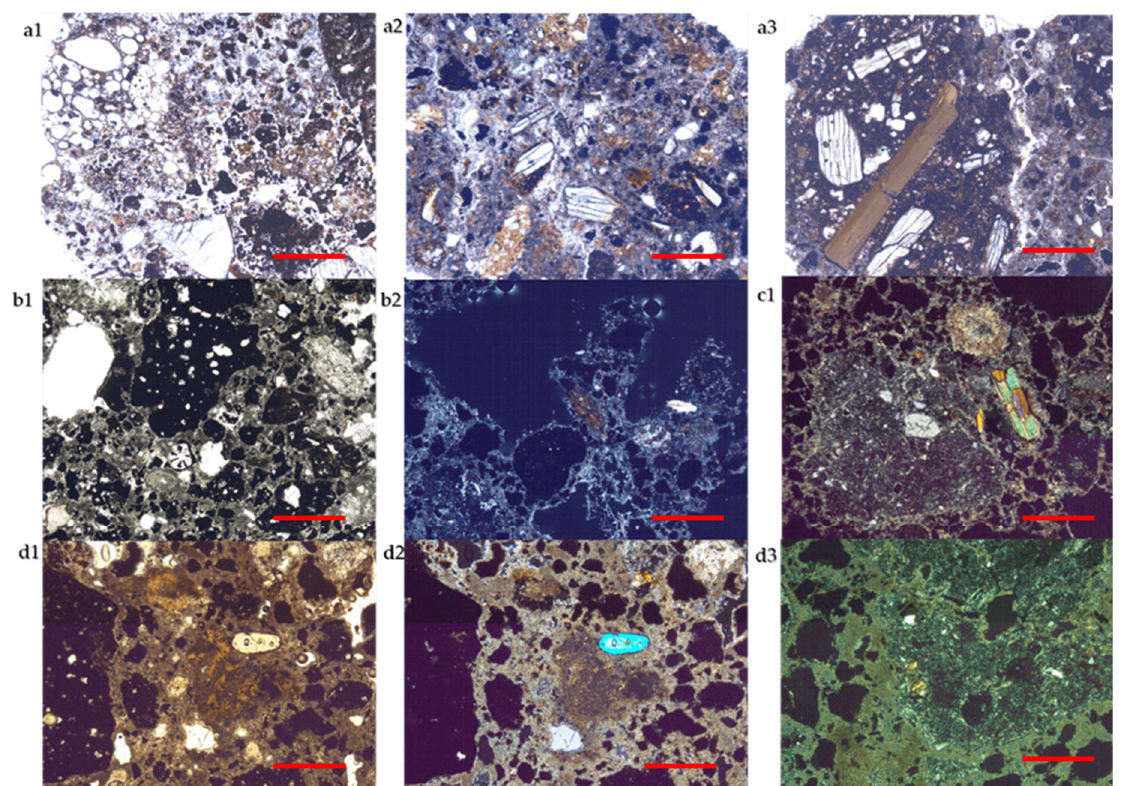
Figure 8. Microphotographs of mortar samples. ( a ) Sample M1 (a1: plane polarized light, a2, a3 crossed polarized light): fragments of pumice and black/red pozzolan are shown; ( b ) sample M2 (b1: plane polarized light, b2: crossed polarized light); ( c ) sample M3 (c1: crossed polarized light); ( d ) sample M4 (d1: plane polarized light, d2–d3: crossed polarized light). All microphotographs are at 4× magnifications. Line red bar = 1 mm.